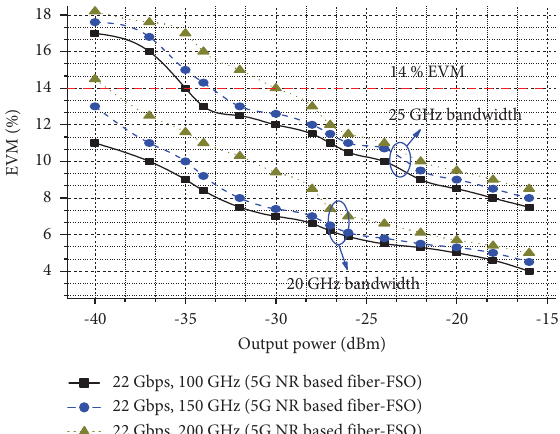
Figure 6: Received power against EVM analysis for diferent bandwidths and 64QAM-OFDM signal frequencies.